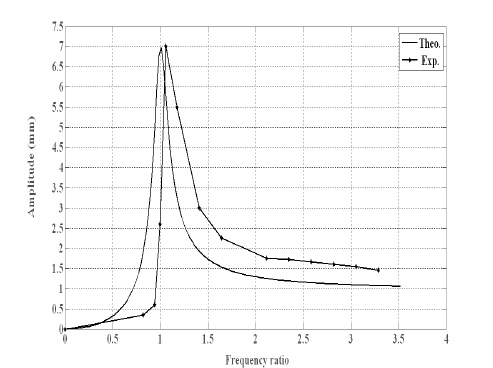
Fig. 11. Shows the varaition of the amplitude versus frequency ratio for m=0.386 kg, and e=0.1 m.